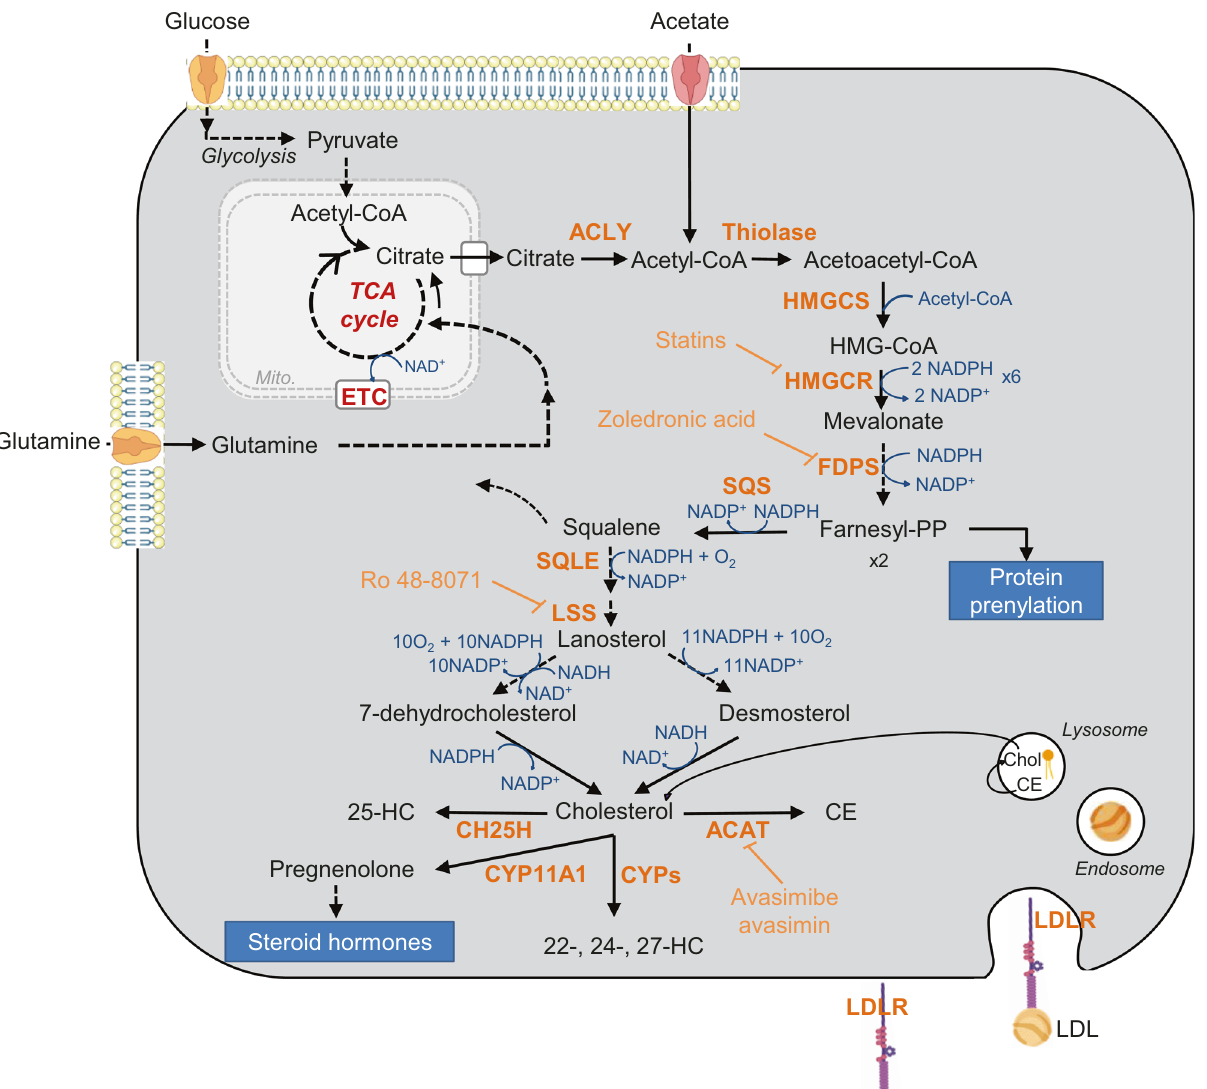
Fig. 2 Schematic representation of key steps of the mevalonate (MVA) pathway leading to sterol and non-sterol isoprenoid synthesis. MVA is produced from acetyl-CoA, through reactions that are catalyzed by the acetoacetyl-CoA thiolase (Thiolase), HMG-CoA synthase 1 (HMGCS1) and HMGCR enzymes. MVA is converted into farnesyl-pyrophosphate (FPP), which with the geranylgeranyl-PP are responsible of protein prenylation. FPP molecules can also be condensed by the squalene synthase (SQS) to produce squalene. Then, squalene is oxidized and cyclized to lanosterol by the squalene epoxidase (SQLE) and lanosterol synthase (LSS), respectively. Finally, lanosterol is converted to cholesterol by 19 oxygen-based reactions through the Kandutsch-Russell or the Bloch pathway. De novo synthetized cholesterol and diet- derived cholesterol taken up through the LDL receptor (LDLR)-mediated endocytosis can give rise to cholesteryl esters, hydroxycholesterol (HC) or steroid hormones. HMG-CoA 3-Hydroxy-3-methylglutaryl-coenzyme A, ETC electron transport chain, TCA tricarboxylic acid, CE cholesteryl ester, Chol. cholesterol, 22-, 24-, 25- and 27-HC 22-, 24-, 25- and 27-hydroxycholesterol, CH25H Cholesterol 25-hydroxylase, CYP11A1 cytochrome P450 family 11 subfamily A member 1, CYPs cytochrome P450 enzymes, LDL low density lipoprotein. Indirect and direct chemical reactions are illustrated by dotted and solid arrows,